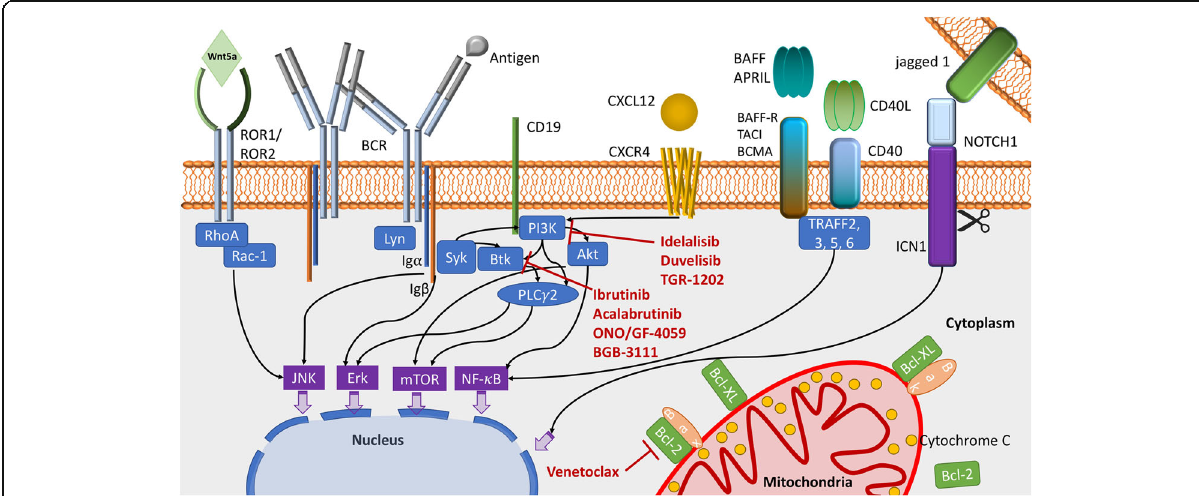
Fig. 1 CLL main pathogenic pathways and target agents against BTK, PI3K and Bcl-2. BCR signaling is induced by the recognition of an antigen or by self-binding, Lyn promotes the phosphorylation of Iga and Igb that activates the spleen tyrosine kinase (Syk). Syk then triggers the formation of a multi-component ‘ signalosome ’ , including Btk, Akt, PI3K and PLC γ 2 among others. BCR co-receptor CD19 is important for PI3K activation, which recruits and activates PLC γ 2, BTK and AKT. These leads to the activation of the c-Jun N-terminal kinase (JNK), MEK – extracellular signal-regulated kinase (ERK), mechanistic target of rapamycin (mTOR) and (NF- κ B) signaling pathways. In addition, CLL cells activate these and other prosurvial, activatory pathways by their interaction with many soluble and surface factors. As an example: Wnt5a interact with the ROR1/ROR2 dimers promoting the activation of RhoA and Rac-1. CXCR4/CXCL12 engagement activates PI3K and downstream pathways, in addition other molecules. The TNF receptors CD40, BAFF-R, TACI and BCMA interact with their ligands CD40L or BAFF and APRIL, inducing the activation of the canonical and alternative NF- κ B pathways depending on the TNF receptor-associated factor (TRAF). NOTCH1 signaling is initiated by the binding with one of the five ligands (e.g. jagged 1, Delta-like ligand 1 (DLL1)), followed by the release of the intracellular active portion (ICN1), enabling its migration into the nucleus. These pathways lead to the upregulation of anti-apoptotic molecules like Bcl-2, Bcl-XL and Mcl-1, sequestering the pro-apoptotic molecules Bax and Bak, and inhibiting the intrinsic apoptosis pathway. Inhibitors for PI3K, BTK and Bcl-2 are indicated in